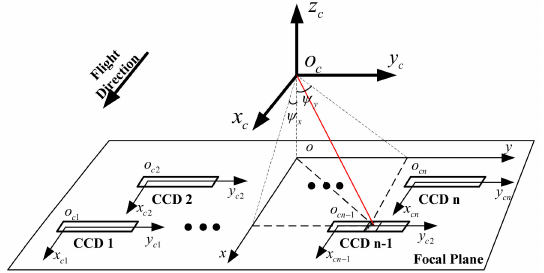
Figure 4. Optical butting diagram of ZY-3 three-line array